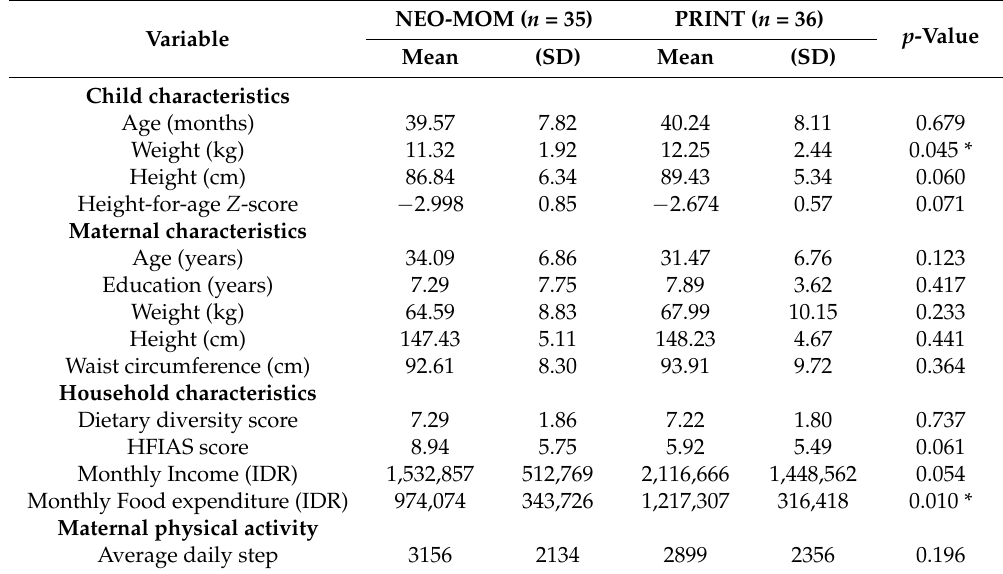
Table 1. Participants characteristics at baseline ( n =